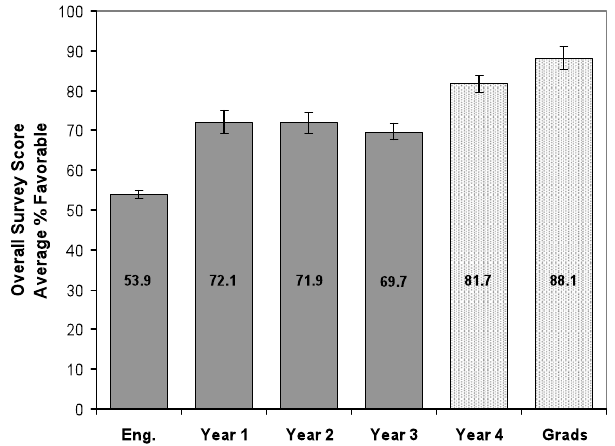
FIG. 1. Average percentage of favorable responses. Error bars indicate the standard deviation of the mean. Year 4 and grad data are grayed out to indicate a small number of responses for these groups.